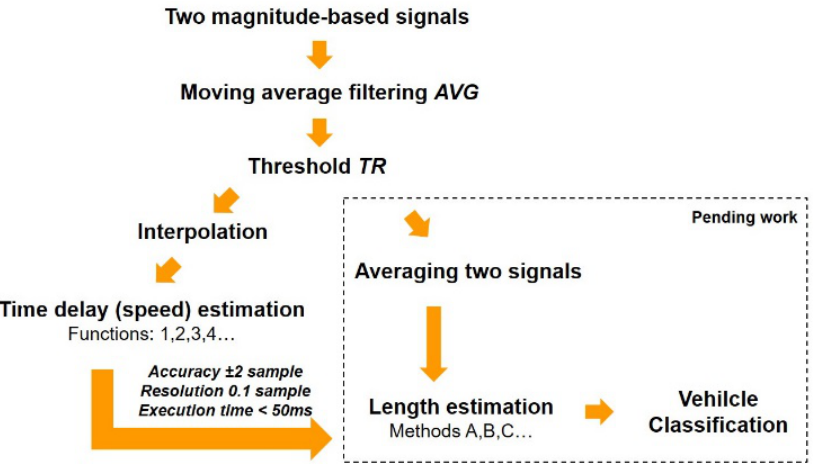
Figure 9. Computation of sample delay as a preliminary task before a vehicle’s length estimation and vehicle classification.